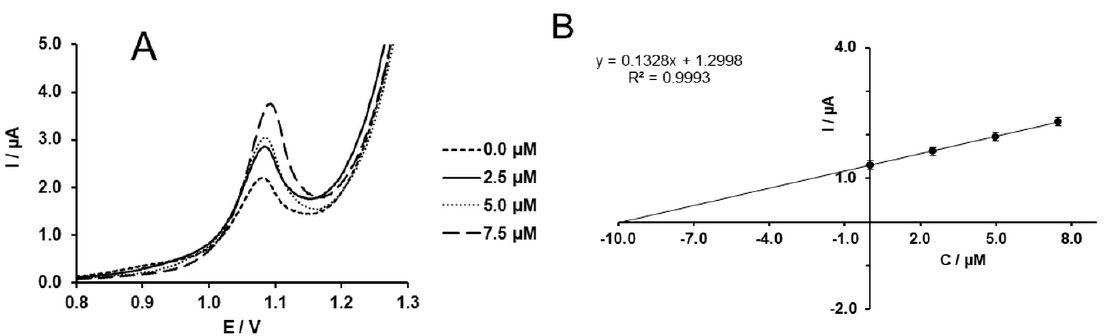
Figure 9. ( A ) DPVs of solution of 7.5 µ M SIM prepared in tablet form and three standard additions of 5 µ M, 7.5 µ M, and 10 µ M; ( B ) standard addition curve in which the extrapolations show the initial concentration of SIM in the measuring solution.